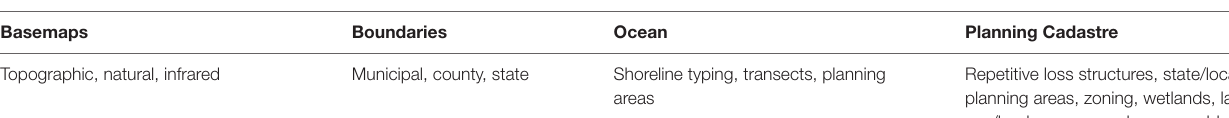
TABLE 2 | Typical GIS layers in NJcoast municipal data catalogs (grouped by ISO